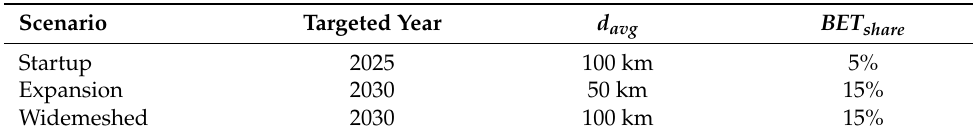
Table 2. Scenario definition.